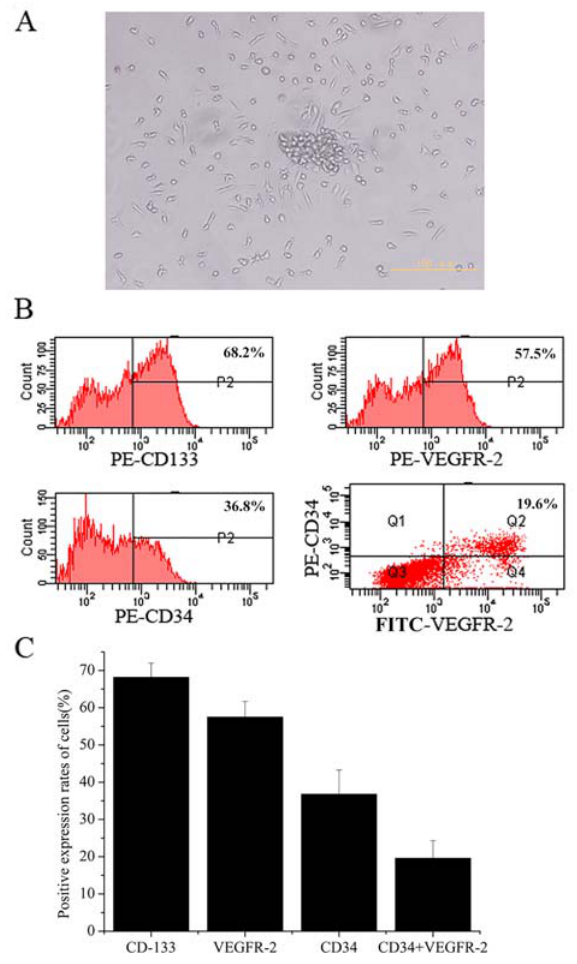
Figure 1. Isolation and culture of endothelial progenitor cells (EPCs). A , After 1 week, EPCs showed a fusiform shape and grew as a classic cell colony (scale bar 100 m m). B , In mononuclear cells cultured for 7 days, the positive rates of CD133, VEGFR-2, and CD34 were 68.2 ± 3.8, 57.5 ± 4.2, and 36.8 ± 6.5%, respectively. The double-positive expression rate of CD34 and VEGFR-2 was 19.6 ± 4.7%. C , Bar graph of panel B. Data are reported as means ±